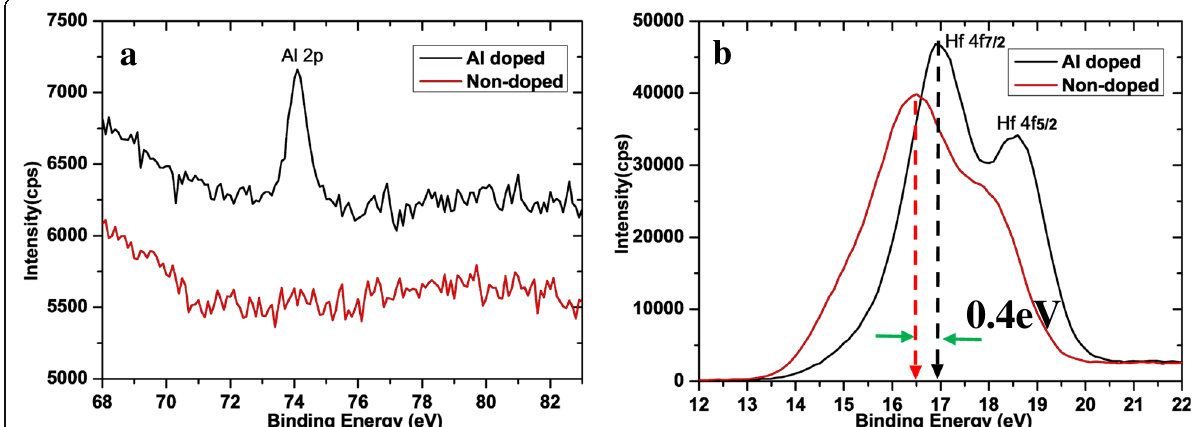
Fig. 2 The XPS of Al-doped and non-doped devices. a Al 2p and b Hf 4f are